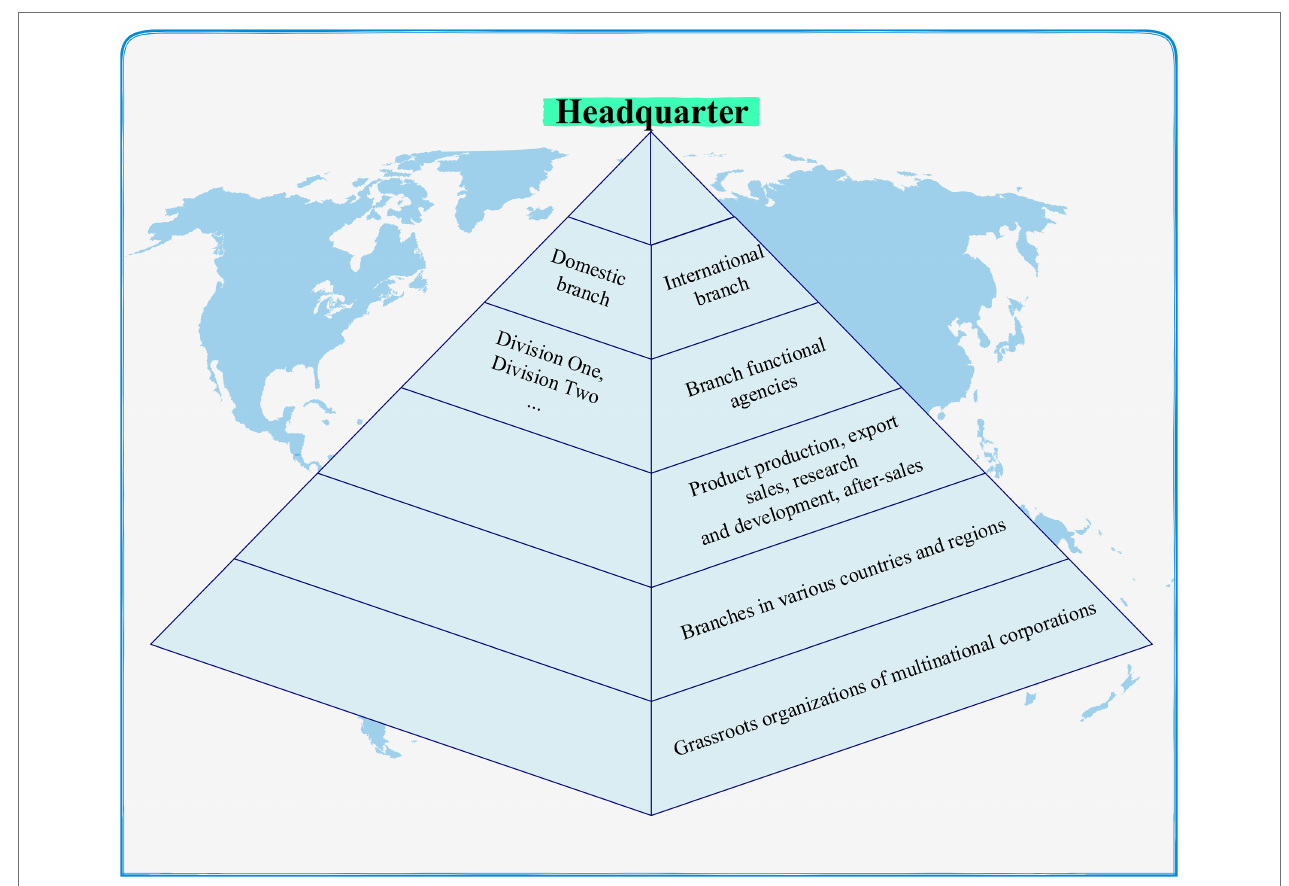
FIGURE 3 | Multinational enterprise gold tower structure